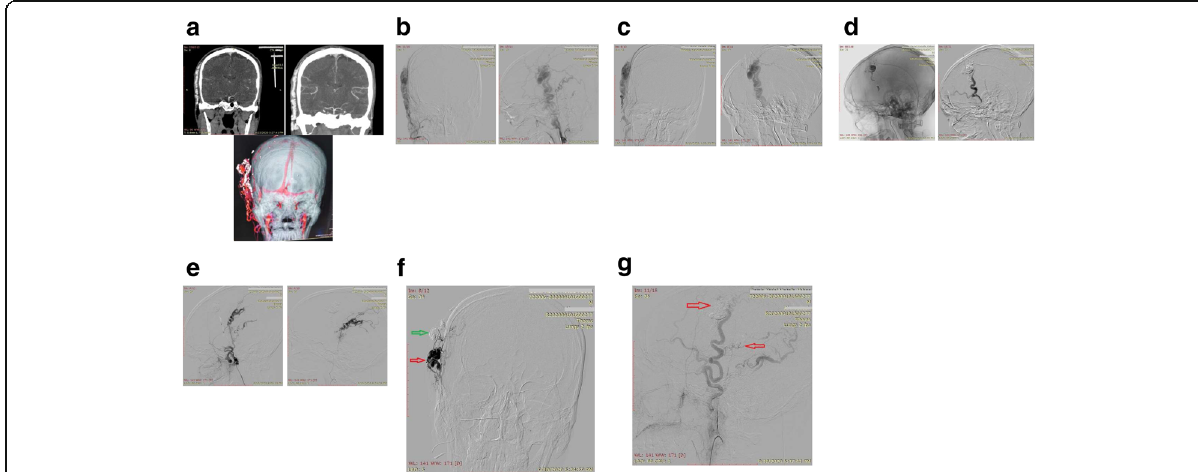
Fig. 3 A 39-year-old male patient presented by a large right frontoparietal cirsoid aneuyrsm. a Coronal sections of CTA demonstrating a large right frontoparietal cirsoid aneuyrsm with MIP and VR images showing the superficial temporal artery as the main feeder. b DSA showing the cirsoid anueyrsm using the macro-catheter in AP and lateral projections. c DSA showing the cirsoid anueyrsm using the micro-catheter in AP and lateral projections. d DSA showing glue within the cirsoid anueyrsm which is totally occluded at post-embolization angiogram super-selectively. e Post-embolization angiogram via the macro- and micro-catheters revealed another active small component, which became more evident after occlusion of the original large one. f Another DSA image showing the residual active small component (red arrow) in the AP projection. Note the superiorly related totally occluded original large one (green arrow). g Post-embolization angiogram revealed total occlusion of the residual active small component as well as the original large